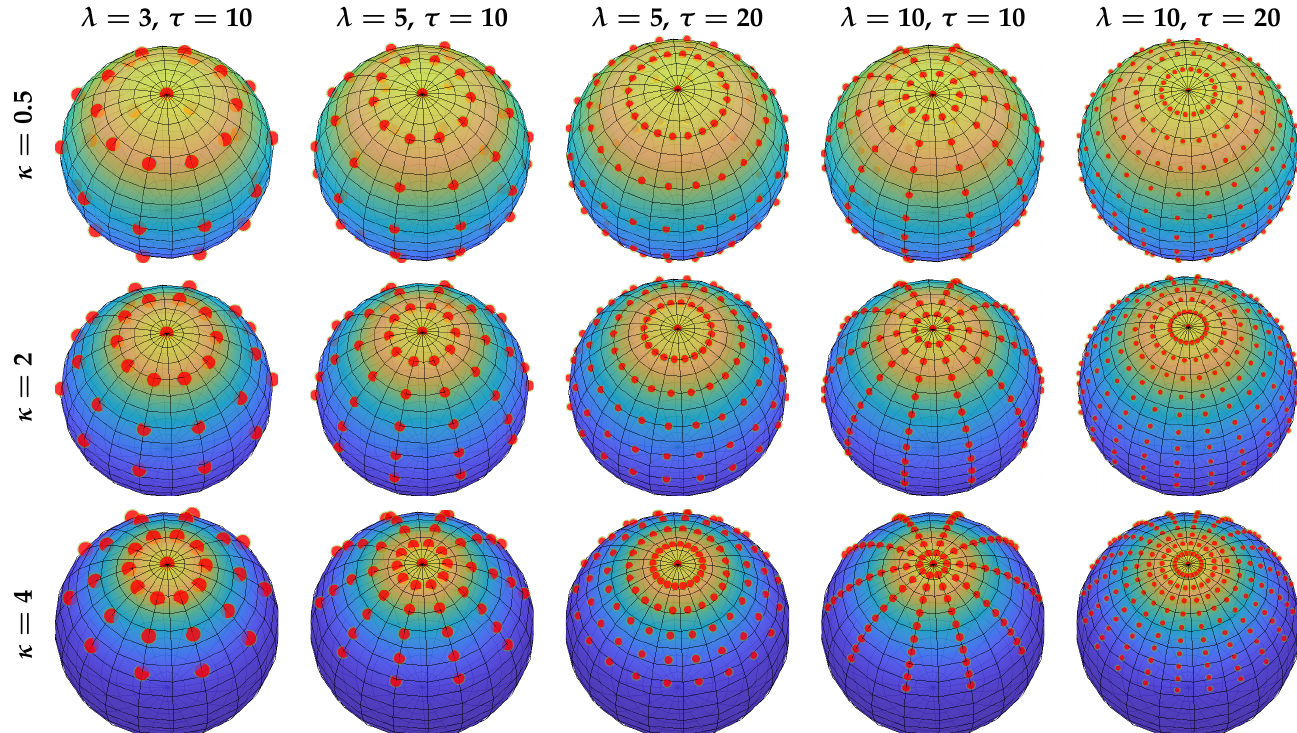
Figure 2. Illustration of the proposed isotropic deterministic sampling schemes with von Mises–Fisher distributions on S 2 of different parameterizations in Section 3.2. Samples (red dots) are uniformly weighted and dotted with sizes proportional to weights.